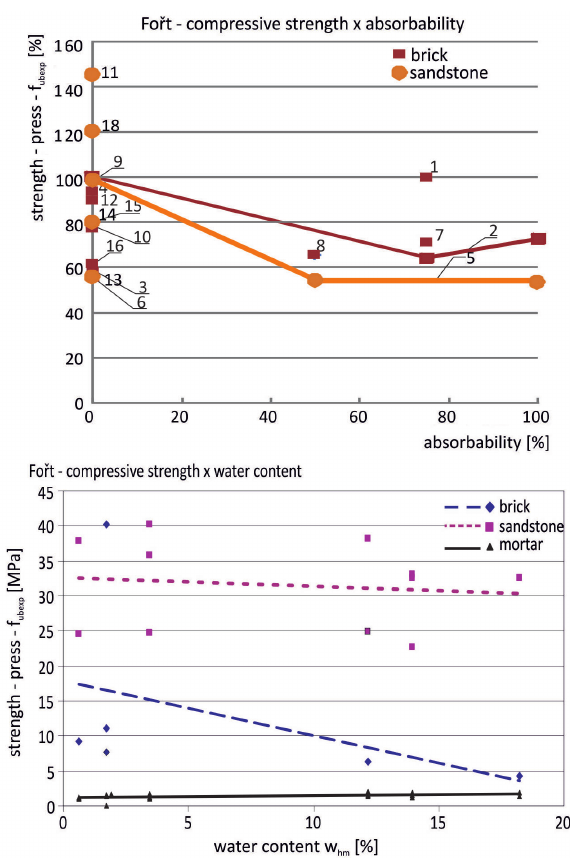
sandstoneFig. 4. Comparison of compressive strengths of masonry units obtained by a press (reference value (100%) is the strength in the point